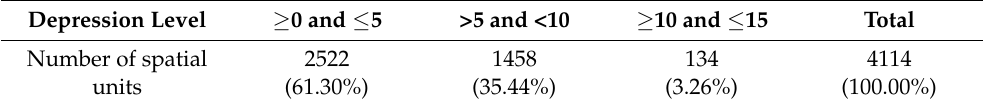
Table 4. Number of Eup, Myeon, and Dongs at each depression